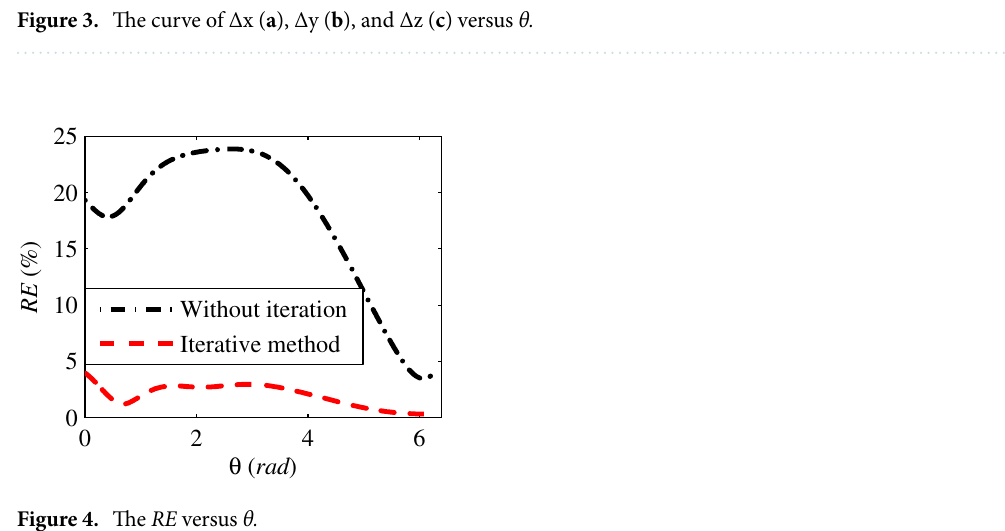
where r est presents the estimated bearing vector, whereas r ideal is the ideal (i.e. theoretical) bearing vector. RE versus θ is presented in Fig. 4. It is shown that the accuracy of the proposed iterative method was much higher than that of without iteration. The RE without iterative was even more than 20%, however, the RE with iterative method was kept below the level of 5%. If we assume that the RE is acceptable when it is less than 5%, then, the estimated bearing vector by the proposed method can be seen as the true position of the target with respect of any θ .